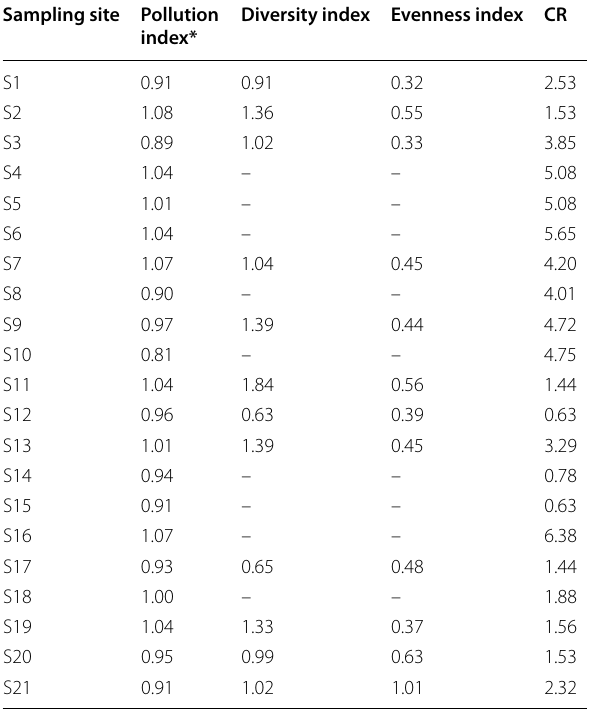
*Represents the mean values of the pollution index of inorganic nitrogen and active phosphate, because only the measured concentrations of inorganic nitrogen and active phosphate exceededthe 4th category seawater quality standard